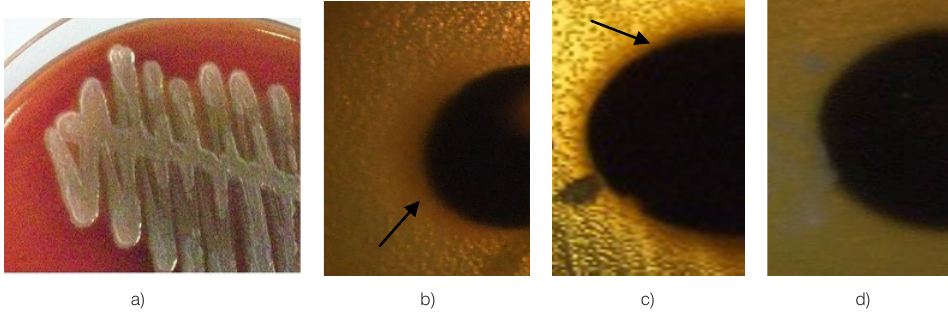
Figure 5. The alloys in contact with P.aeruginosa : a) Pure culture b) Zr2,5Nb c) Zr10Nb d) Table 6. Electrochemical parameters obtained from Tafel slopes processing. Alloy